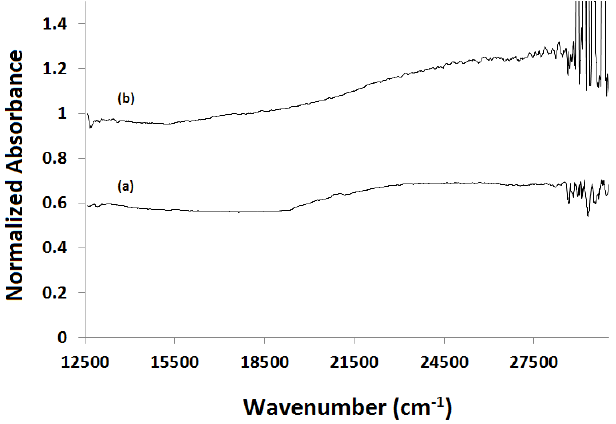
Figure 12. Ex situ analysis after 240 h of WGS reaction. The spectra shown are normalized absorbance for ( a ) used 0La catalyst; ( b ) used 1La catalyst.